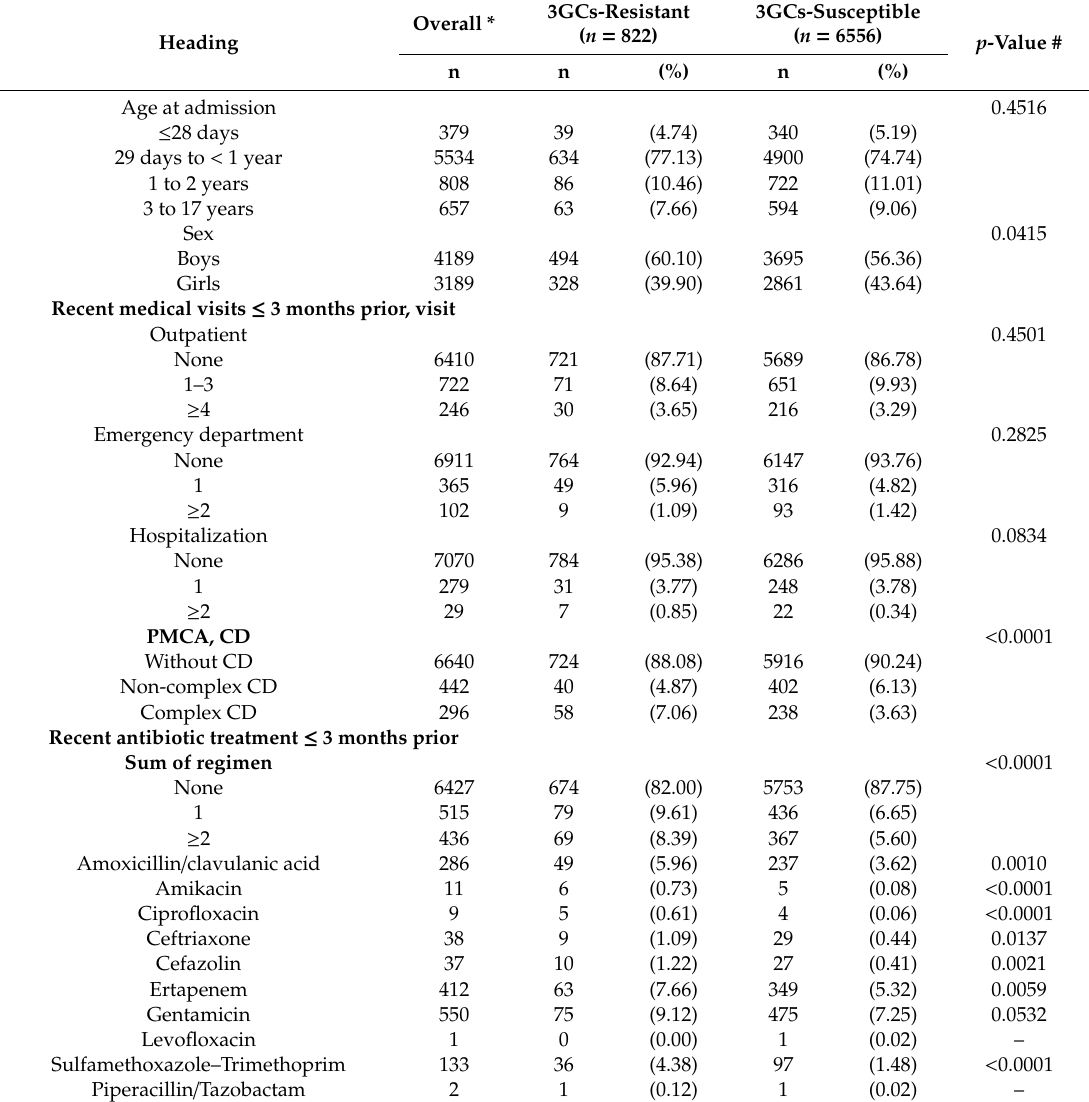
Table 2. Characteristics of children with community-associated E. coli urinary tract infection,